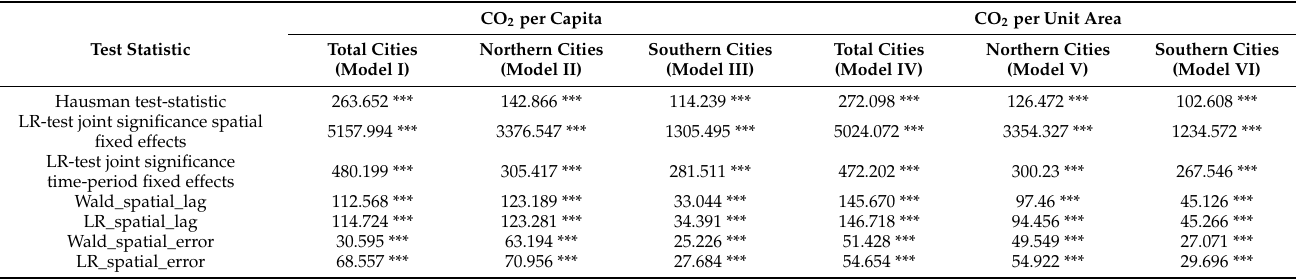
Table 1. Related